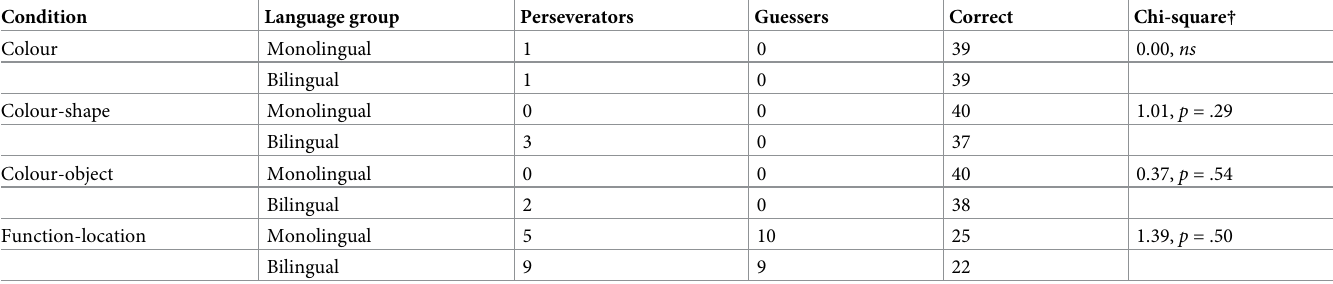
Table 1. Monolinguals and bilinguals performance in DCCS task and Chi-square results.